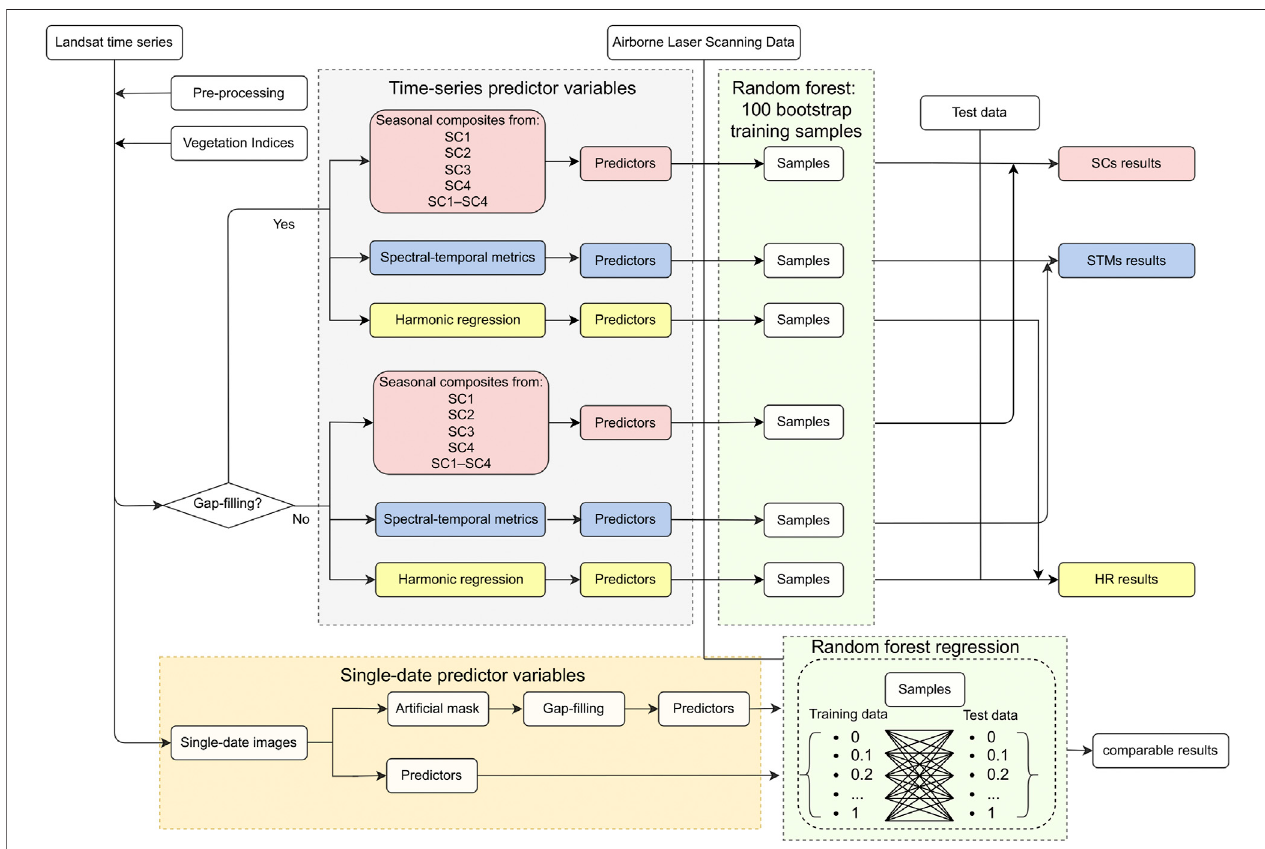
FIGURE 1 | Flowchart of the tree canopy cover modelling experiments using bootstrap sampling random forest regression. Abbreviations: SCs: seasonal composites; STMs, spectral-temporal metrics; HR, harmonic regression.